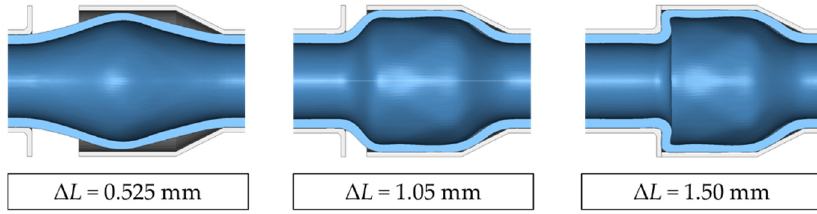
Figure 17. Deformation behavior of the small ZM21 tube in the cylinder-shape warm THF obtained by